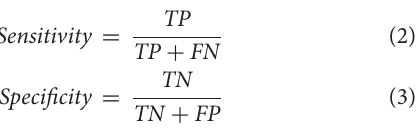
Frontiers in Neuroscience |